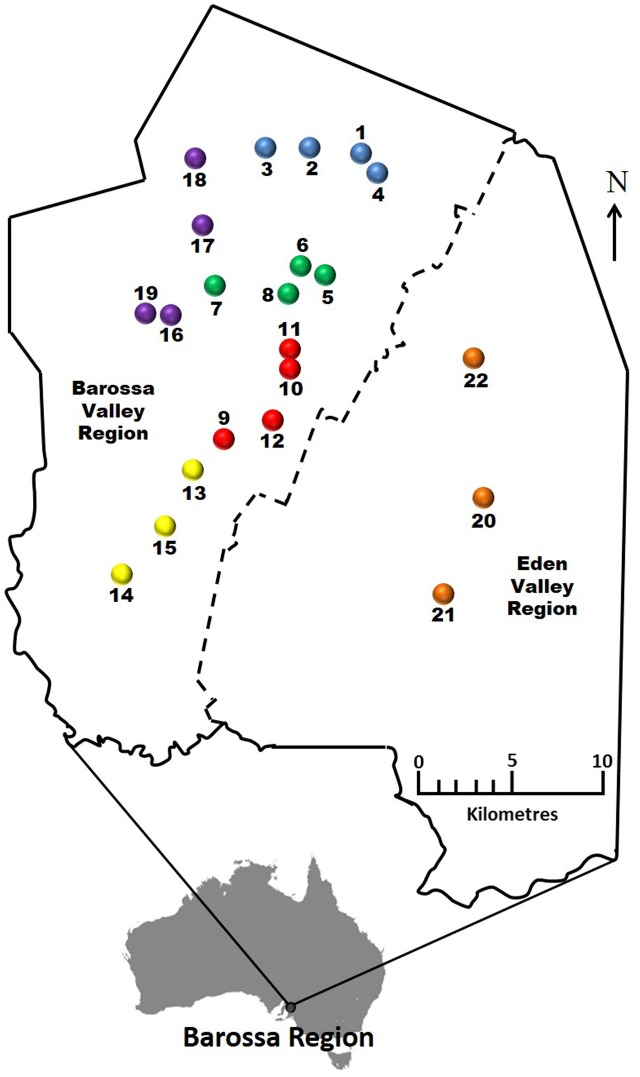
Selected Barossa region vineyard sites. Northern Grounds: Blue, Southern Grounds: Yellow, Central Grounds: Green, Eastern Edge: Red, Western Ridge: Purple, Eden Valley: Orange. Arrow indicates geographic north.